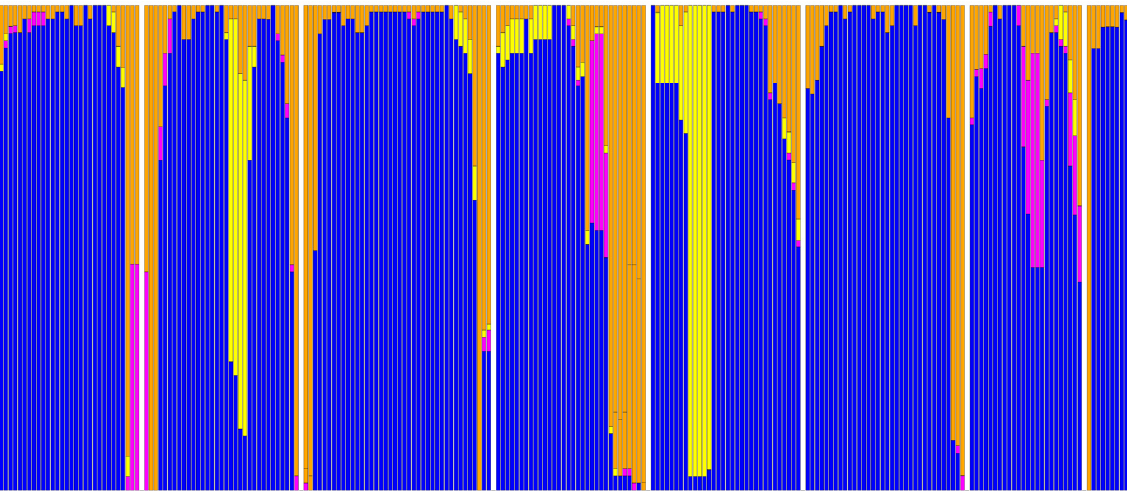
helix; 69 structures used in this study. Blue: α -helix; yellow: α -bulge/ π -helix; purple: 3 10 orange: loop, strand, and turn. Each vertical bar is 69 residues high and the fraction of the bar in a certain color corresponds to the fraction of residues with the corresponding secondary structure. Secondary structures were determined with DSSP 2.0. The plot contains all transmembrane residues plus a few residues into the loop areas that all 69 structures have in common. In most α -bulge areas, one residue is therefore not counted. Small white bars represent the elements between the transmembrane regions that are not structurally conserved throughout the 69 structures. The central part of helix VII is either a regular helix, or consists of a stretch of 3 helix combined with a bulge or similar 10 irregularity. Despite bulges and 3 stretches, the part of helix VII that ends with the 10 conserved NP motif at positions 729 and 730 always has equally many residues so that no residue numbering differences can be observed between